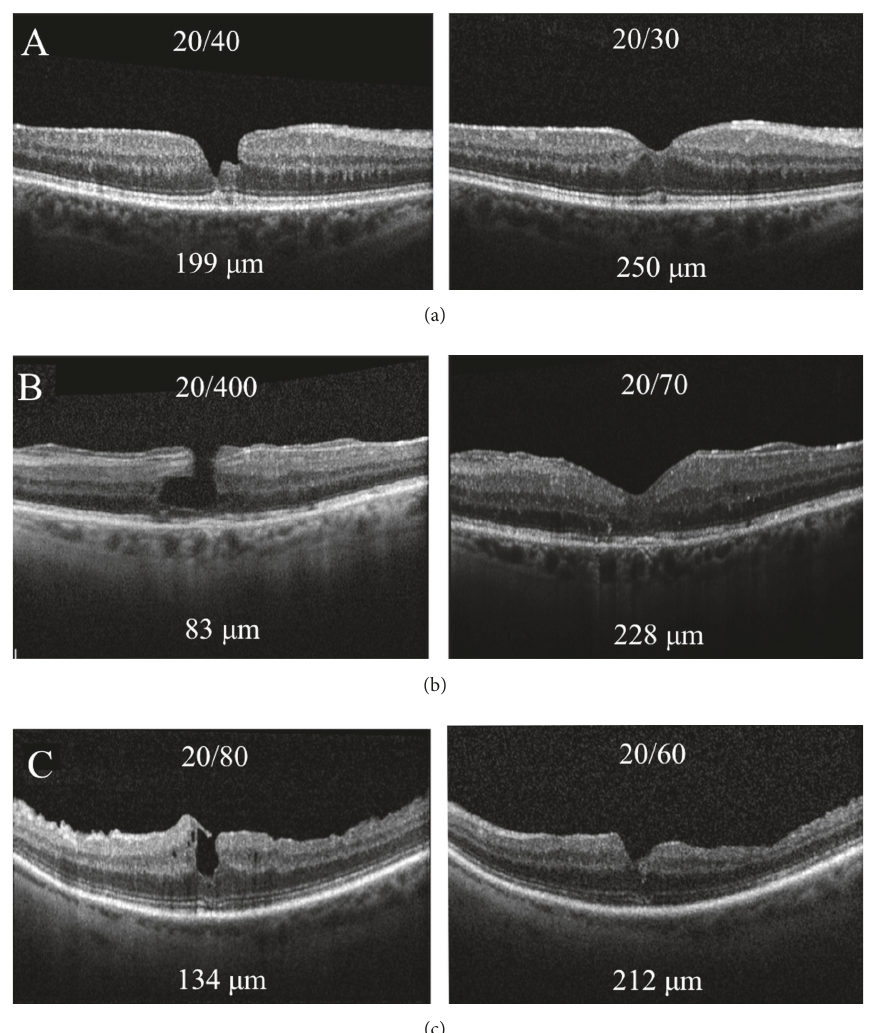
Figure 1: OCT images of Patients 1-3 (a-c) prior to surgery with respective visual acuities and CMT (left) and OCT images at last follow-up with respective visual acuities and CMT